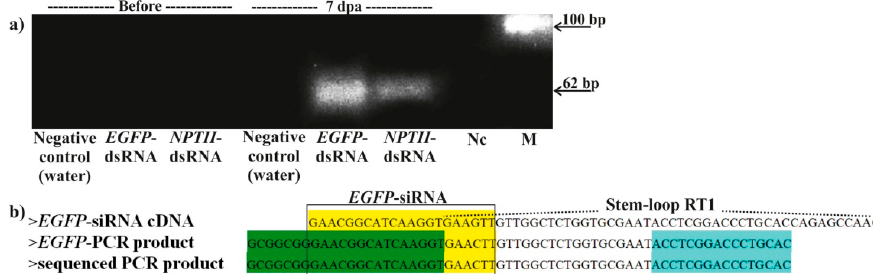
Figure 5. Detection of EGFP -siRNA (NCBI siRNA database acession: Pr008640320 or Pr120179) in the dsRNA-treated and water-treated A. thaliana L1 leaves using stem-loop RT-PCR before treatment and 7 days post application. ( a ) Agarose gel electrophoresis of the stem-loop RT-PCR products. M—low molecular weight DNA ladder; Nc—negative control (RT-PCR mixture without RNA). ( b ) Sequences of the cloned RT-PCR product and predicted stem-loop structure of the target EGFP -siRNA (sense strand) with primer positions. Dashed lines depict position of the stem-loop RT primer; highlighted in green and blue are the forward and reverse primer positions for stem-loop RT-PCR; highlighted in yellow is the EGFP -siRNA sense strand.